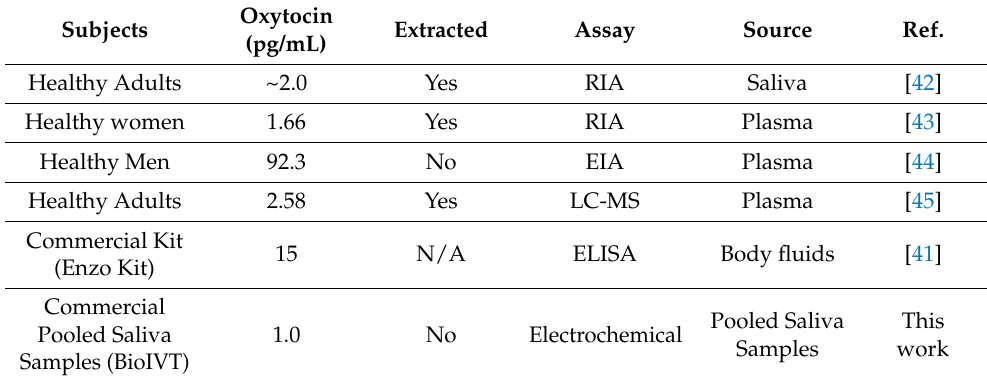
Figure 1. Electrochemical oxytocin detection scheme on aptamer-modified carbon electrode (a-SPE) surface. The proposed oxidation mechanism of oxytocin at the tyrosine moiety. R and R ′ represent the remaining amino acid parts of the oxytocin. Table 1. Summary of Baseline Oxytocin measurement in various studies in human plasma and sa- liva.